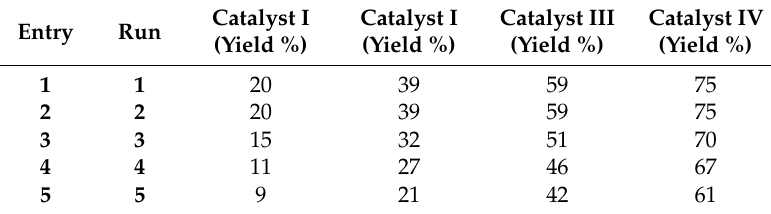
Table 6. Recycling of catalysts I – IV in the oxidation of para -cresol 1 a